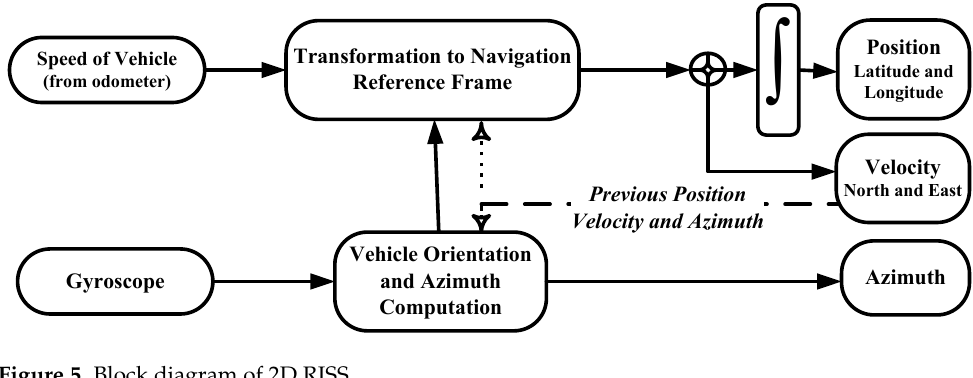
Figure 5. Block diagram of 2D RISS.